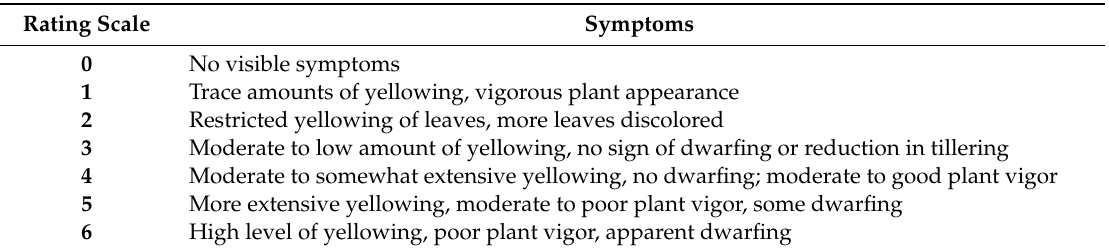
Table 1. Symptoms rating scale based on Schaller and Qualset